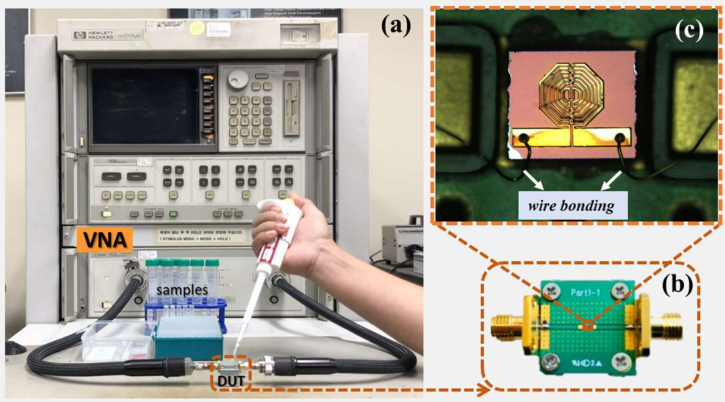
Figure 2. ( a ) Measurement setup including the device-under-test (DUT), test samples, a micropipette for depositing the samples, connection probes, and a network analyzer for examining the performance of the device under varied concentrations of water-ethanol solution. ( b ) Enlarged view of the DUT. ( c ) Microscopic image of the fabricated sensor, which was connected to the planar circuit board through wire